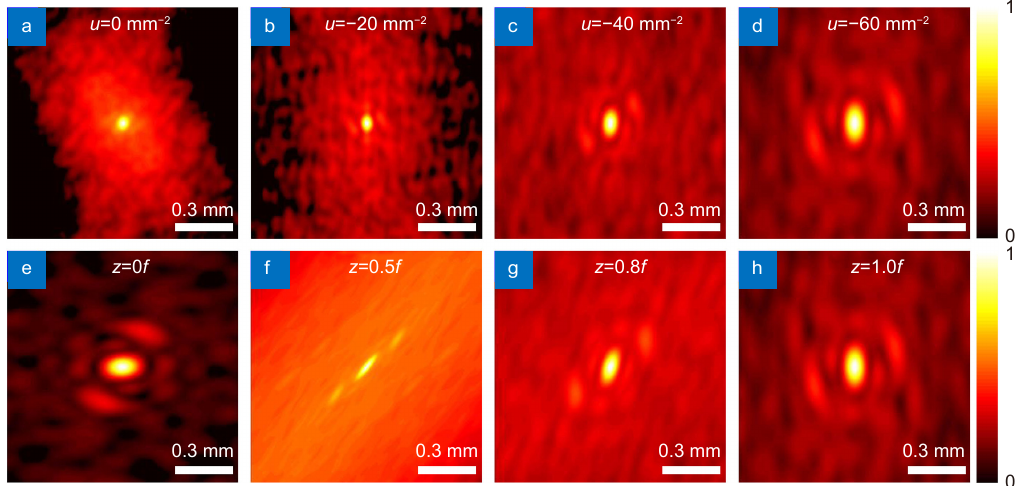
Fig. 4 | ( a − d ) Experimental results of the modulus of the DOC | μ | in the focal plane with different strength factors u. ( e − h ) The modulus of the DOC | μ | at different propagation distances z after the lens with the CP strength factor u =−60 mm −2